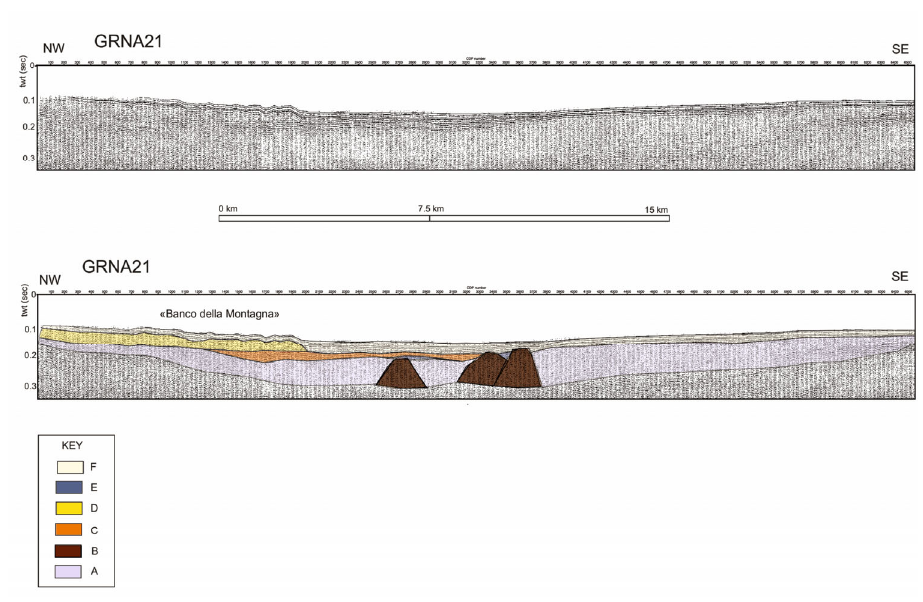
Figure 10. Seismic profile Grna21 and corresponding geologic